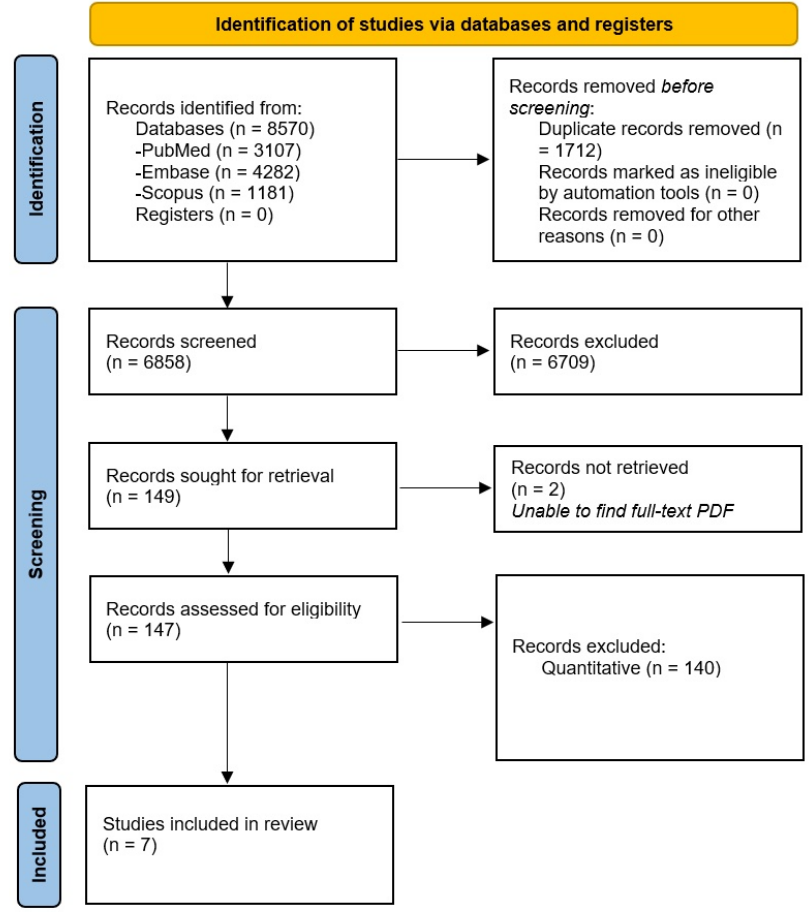
Figure 1. PRISMA Figure 1. PRISMA Diagram.